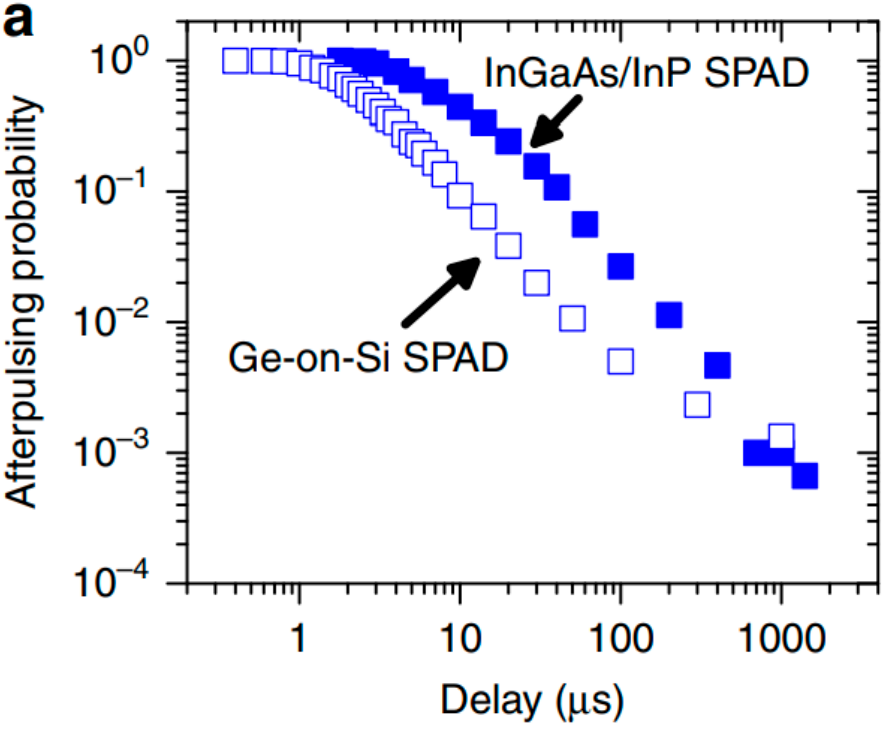
Figure 21. Cross-section diagram of a planar Ge/Si SPAD structure with an i-Ge absorption layer, a p + -Si charge layer, and a i-Si multiplication layer. Reproduced from [77,78], ROS Theses Repository, and Springer Nature, open access, 2019.